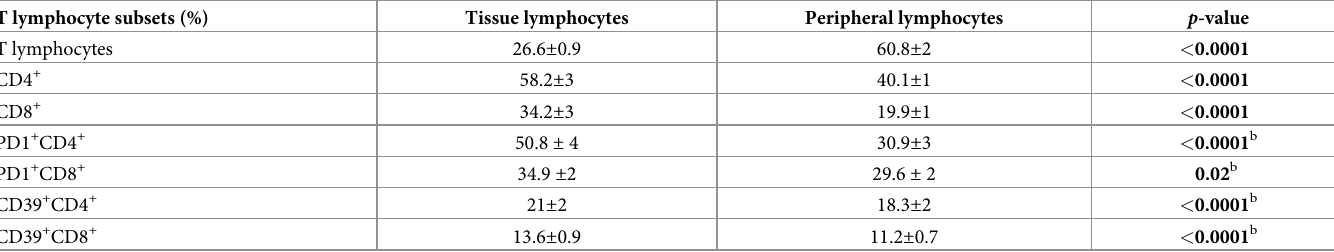
Table 4. Differential expression of PD1 and CD39 among tumor-infiltrating and peripheral blood lymphocytes of patients with triple-negative breast cancer. T lymphocyte subsets (%)